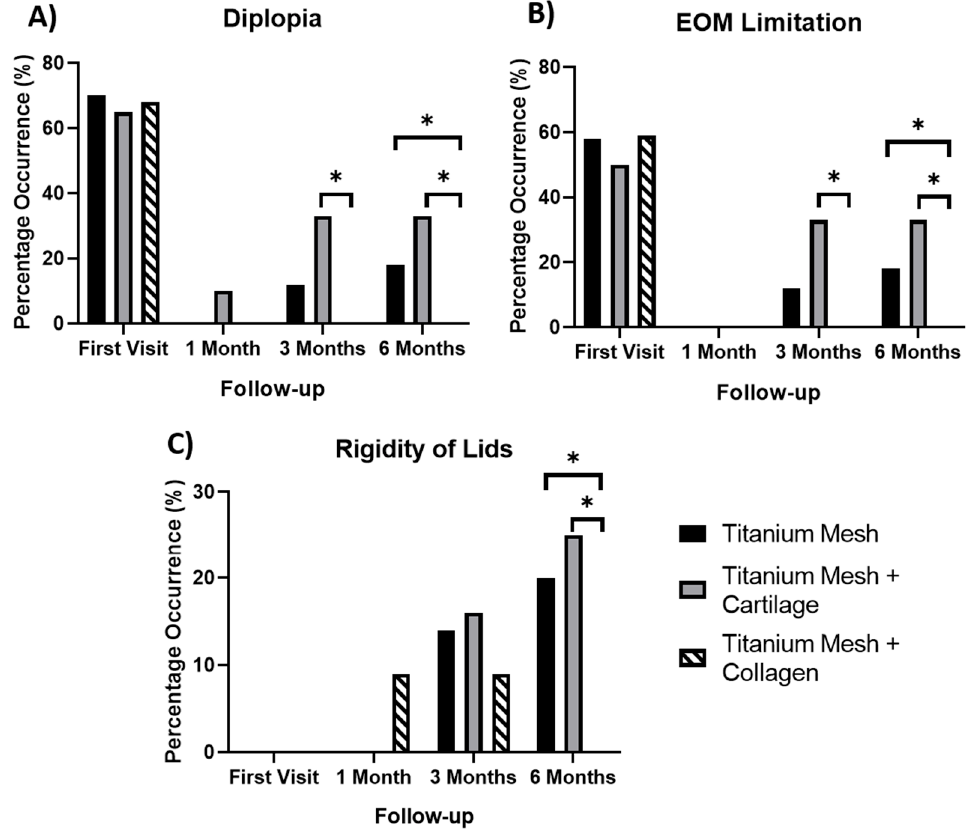
Figure 5. Percentage of occurrence of ( A ) diplopia; ( B ) EOM limitations and ( C ) rigidity of lids, for each time point of the study (* p < 0.05).